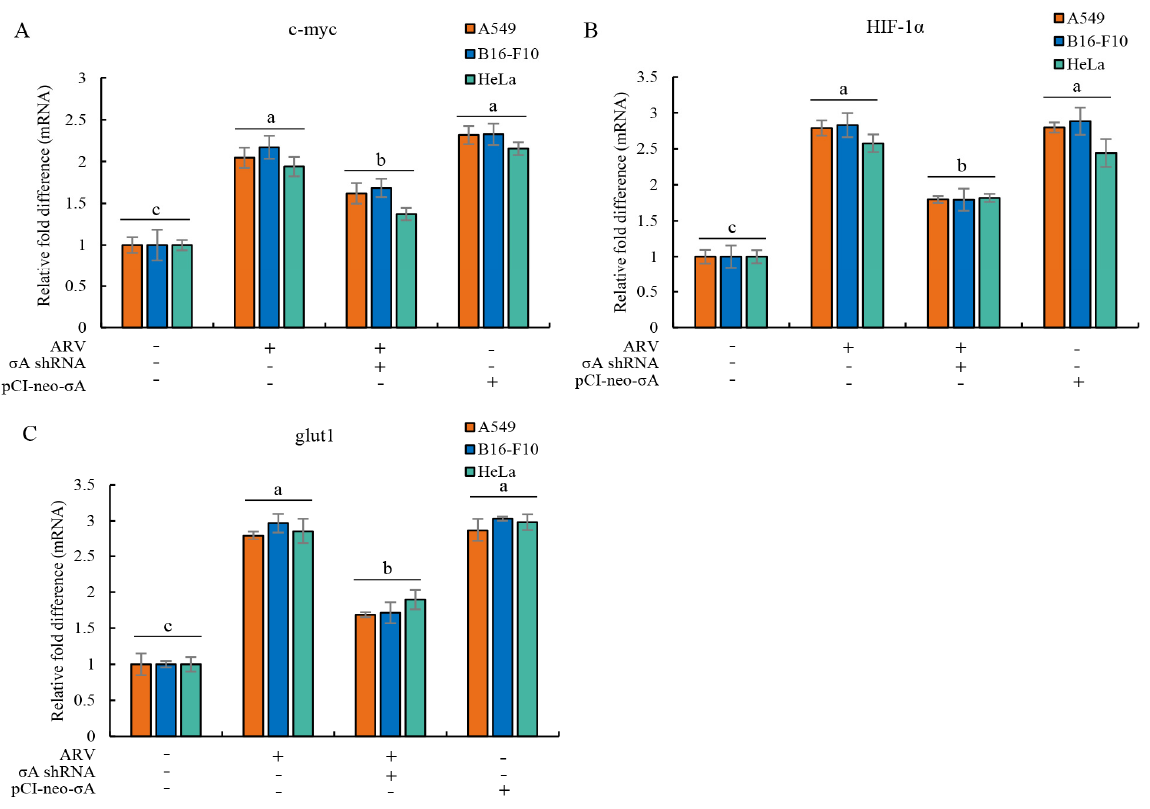
Figure 3. ARV infection and σ A transfection upregulate mRNA levels of c-myc, HIF-1 α , and glut1 in cancer cell lines. ( A – C ) cancer cell lines were infected with ARV or transfection the pCI-neo- σ A or σ A shRNA vectors for 6 h followed by infection with ARV at an MOI of 10 for 18 h. Cell lysates were collected for examining the mRNA levels of c-myc ( A ), HIF-1 α ( B ), and glut1 ( C ) using quan- titative real-time RT-PCR. Each value represents mean± SE from three independent experiments, determined using Duncan’s Multiple Range Test. Similar alphabets (a, b, c) denote no significance at p < 0.05.